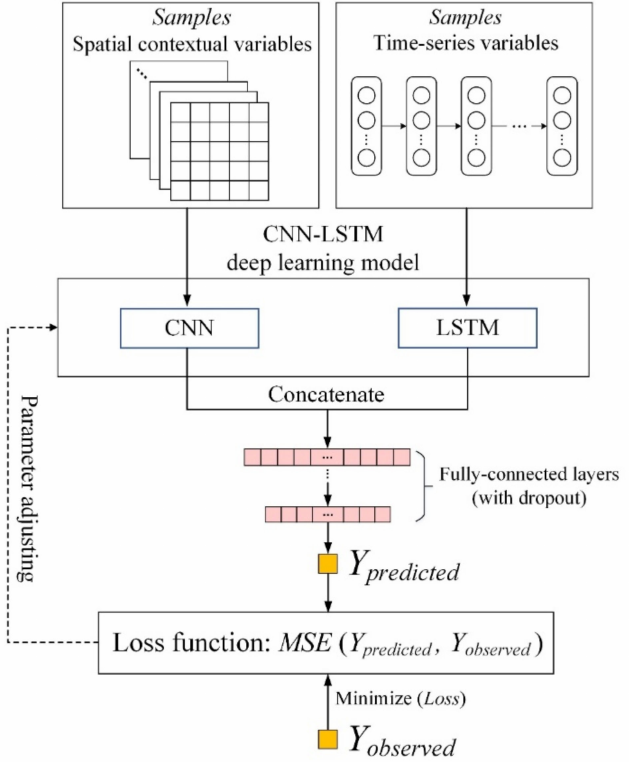
Figure 6. The calibration of the CNN-LSTM model of one iteration step with sample data. The model adjusts its parameters by minimizing the mean-square error (MSE) between the observed and predicted target